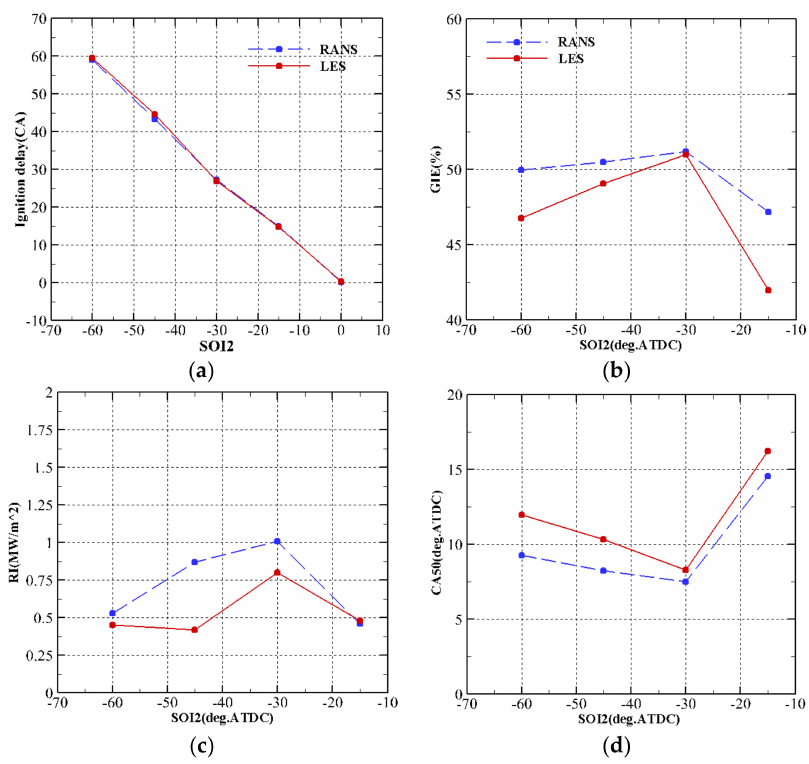
Figure 10. Effects of SOI2 timing sweep on: ( a ) ID, ( b ) GIE, ( c ) RI and ( d ) CA50 for LES and RANS model.